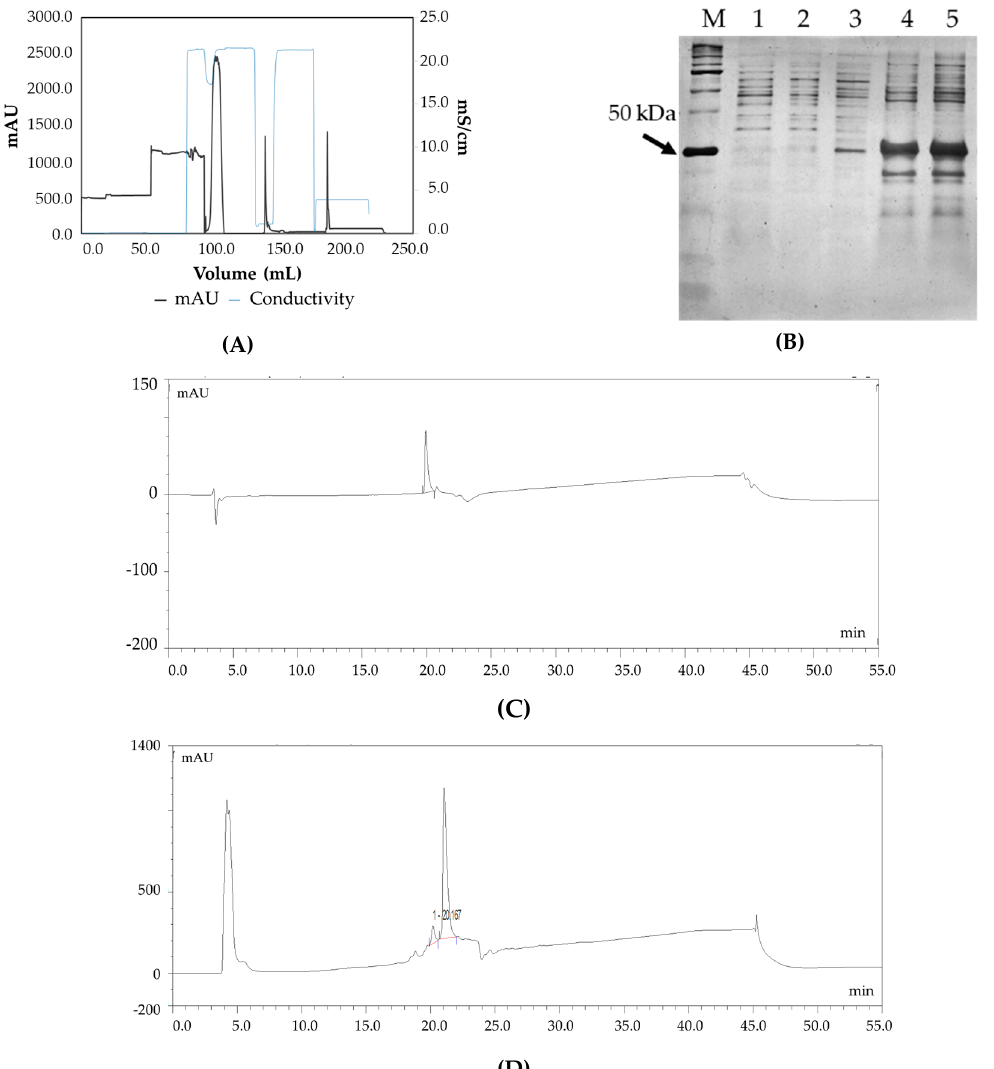
Figure 2. ( A ) Chromatogram of preparative scale purification of the Fab using Capto L affinity chromatography: absorbance (black trace) and conductivity (grey trace) ( B ) Confirmation of Fab molecule by SDS PAGE. Lane M: Protein Marker, Lane 1: Uninduced, Lane 2: Uninduced, Lane 3: Periplasmic extract, Lane 4: Concentrated periplasmic extract, Lane 5: Concentrated periplasmic extract ( C ) RP-HPLC chromatogram of the standard molecule, ( D ) RP-HPLC chromatogram of Fab